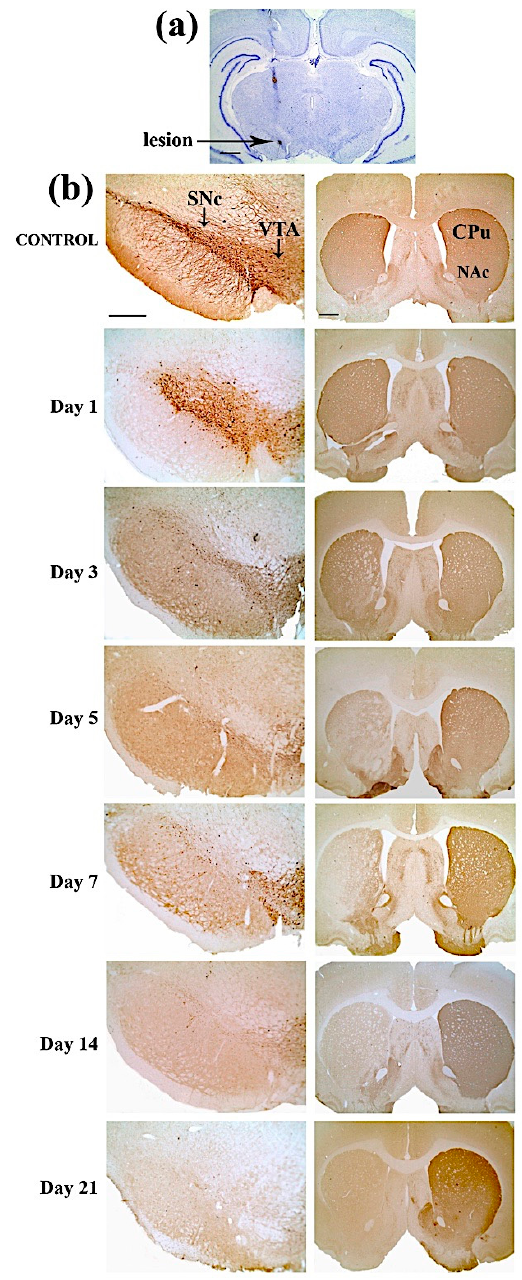
Figure 3. ( a ) Cresyl violet staining of a representative coronal brain section (the arrow indicates the lesion site in the right SNc). Scale bar: 1 mm. ( b ) Time course, for each time point from day 1 to 21 post-lesion, of representative coronal sections for Tyrosine Hydroxylase-immunoreactive (TH-ir) nigral cell (left column) and TH-ir striatal fibers loss (right column) in control (first row) and 6-OHDA lesioned animals. Abbreviations: SNc (Substantia Nigra compacta); VTA (Ventral Tegmental Area); CPu (Caudate Putamen); and NAc (Nucleus Accumbens). Scale bar: 500 µm (left column), 1 mm (right column).